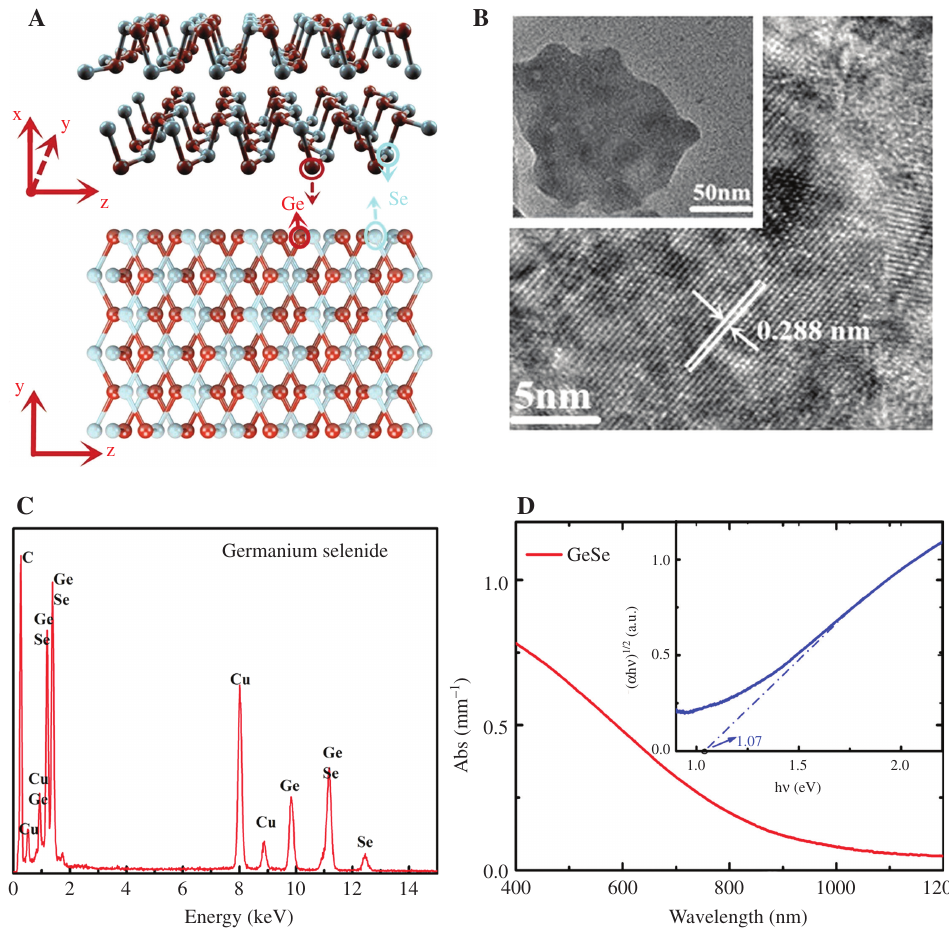
Figure 1: Characterizations of GeSe samples. (A) Side view and top view of the crystal structure of GeSe; (B) high-resolution TEM images of the GeSe NPs; (C) EDX spectrum of GeSe NPs; (D) the linear absorption spectrum of the multi-layer GeSe NPs and Tauc plot (n = 1/2, indirect) for GeSe NPs ( E g = 1.07